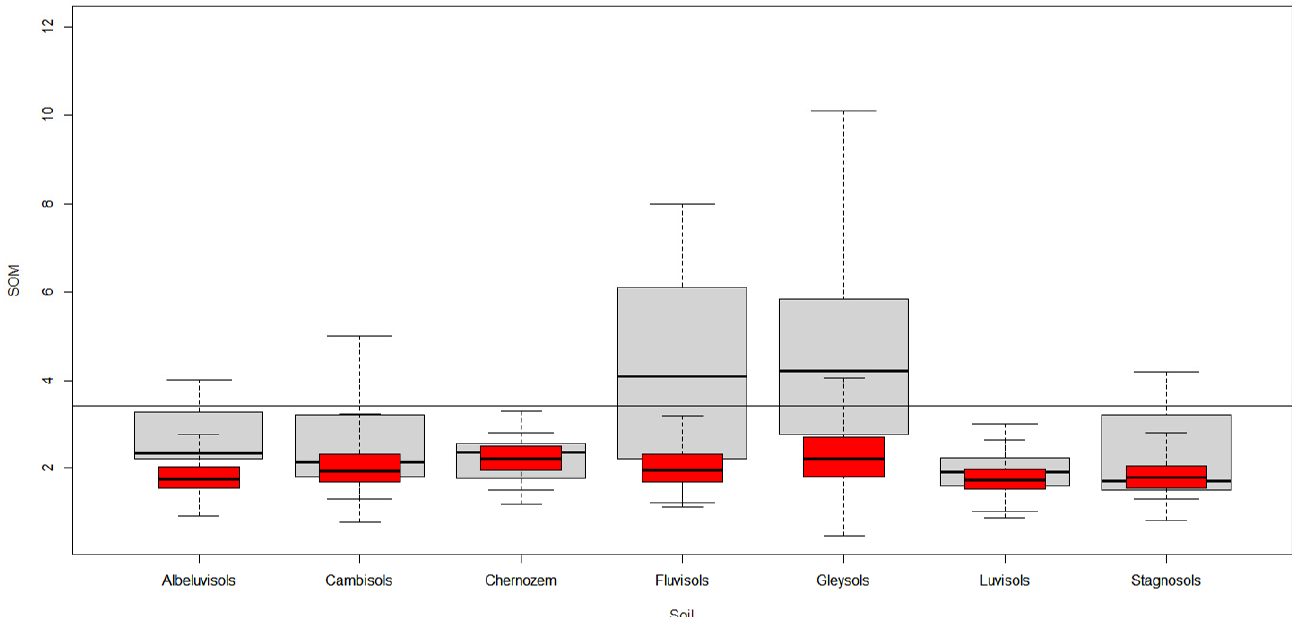
Figure 4. Boxplots of SOM content for SOM2010 (red boxplots) and SOM1970 (grey boxplots), grouped according to soil types. The boxplots depict the minimum, maximum, median, as well as the upper and lower quartiles of the data for each soil class. The horizontal line is in correspondence of the threshold of 3.4% in SOM